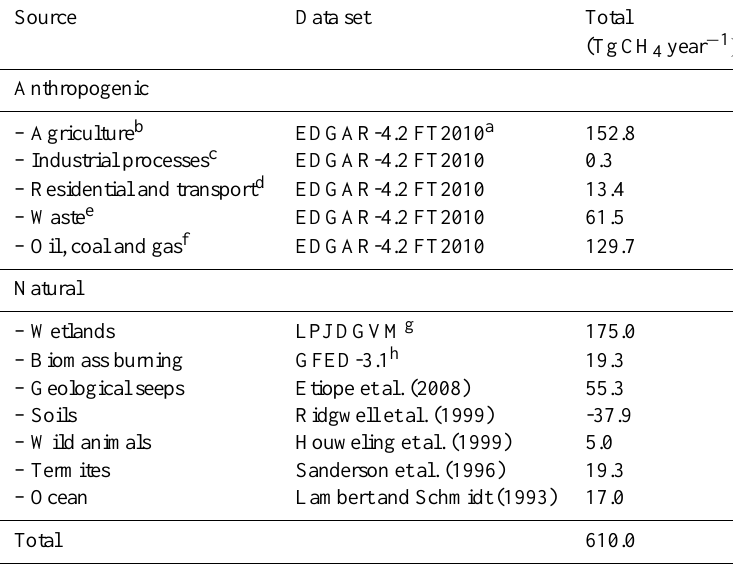
Table 4. Methane flux estimates used in the prior in the case